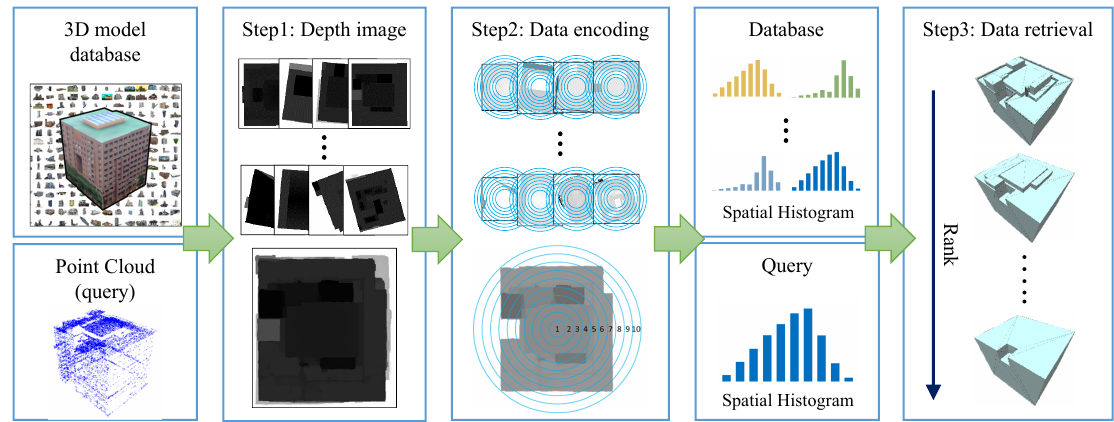
Figure 1. System overview. The system consists of three main steps, depth image generation, data encoding, and data